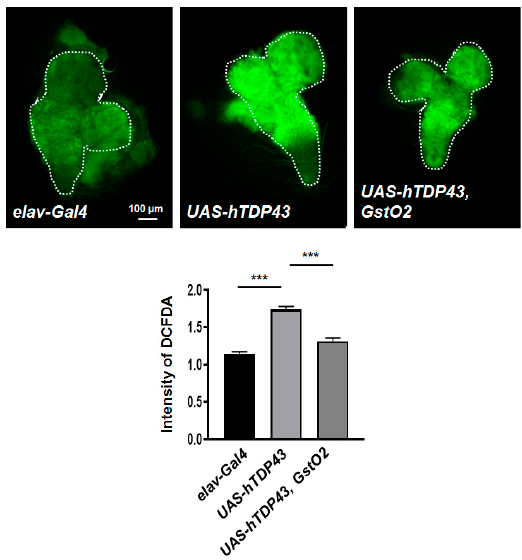
Figure 5. GstO2 reduced the intracellular reactive oxygen species (ROS) generation induced by hTDP-43 in neurons. 2 ′ ,7 ′ -dichlorofluorescin (DCF) fluorescence (green) indicates the presence of ROS. ROS levels in hTDP-43-overexpressing larvae increased compared to the control larvae. Overexpression of GstO2 suppressed ROS production in hTDP-43-induced larvae. Quantification of DCF fluorescence intensity in whole brains (dotted line) was performed by ImageJ software and normalized to the value of the elav-Gal4 control flies. Statistical significance was determined using the unpaired Student t -test (*** p < 0.001, n > 6 for each genotypes). Error bars indicate SEM.